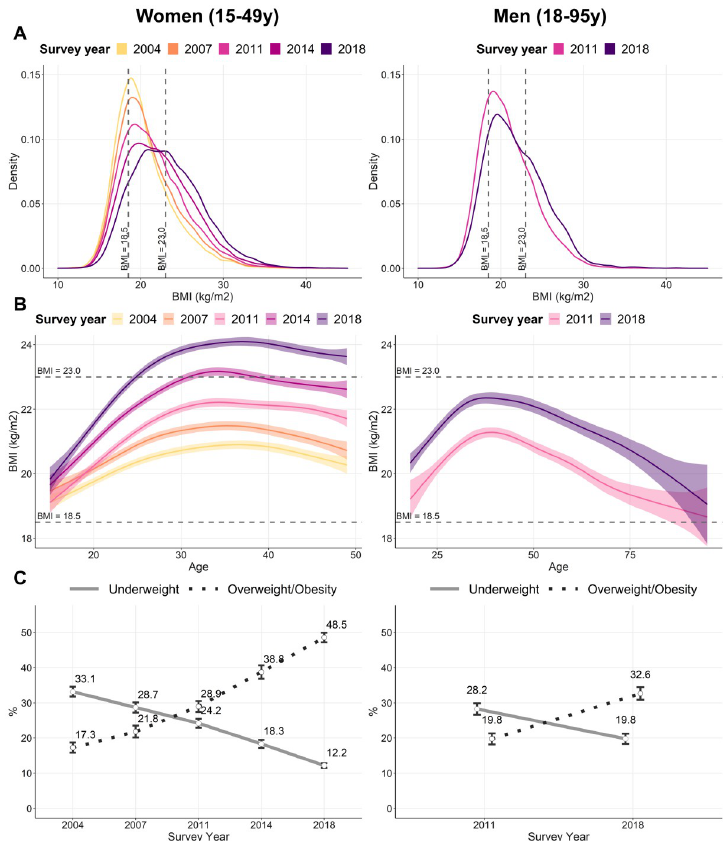
Fig 1. Trends in BMI, overweight/obesity, and underweight among women and men by survey round, Bangladesh 2004–2018 1 . (A) Distributions of BMI by survey round. (B) Distributions of BMI by age and survey round. (C) Prevalence of underweight and overweight/obesity by survey round. 1 Underweight was defined as BMI < 18.5 kg/m 2 and overweight/obese as BMI � 23 kg/m 2 , according to the criteria for Asian populations. Values in (A) and (B) are mean and 95% confidence interval bands. Values in (C) are mean and 95% confidence interval